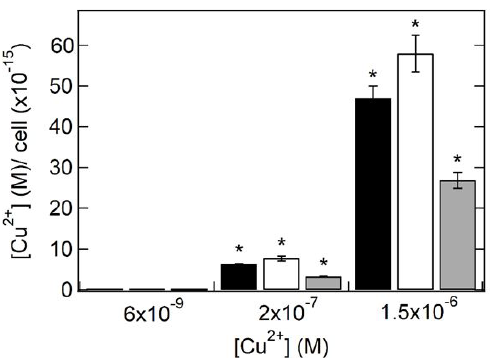
Figure 2. Free copper concentration per cell of Chlorella. sorokiniana ( ■ ), Kirchneriella obesa ( □ ) and co-cultivation ( ■ ) as a function of the three copper concentrations tested. Error bars represent the mean ± standard deviation. The symbol * represents statistically significant difference (p < 0.05) regarding the